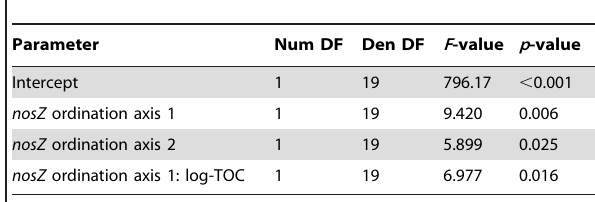
Table 3. Results from an ANOVA conducted to determine the significance of fixed effects on the final linear mixed-effects model (with interactions) of